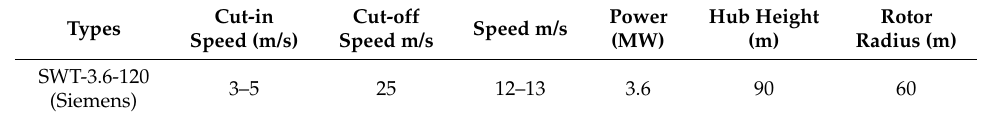
Table 3. Main parameters of the wind turbine installed in NNW, USA.